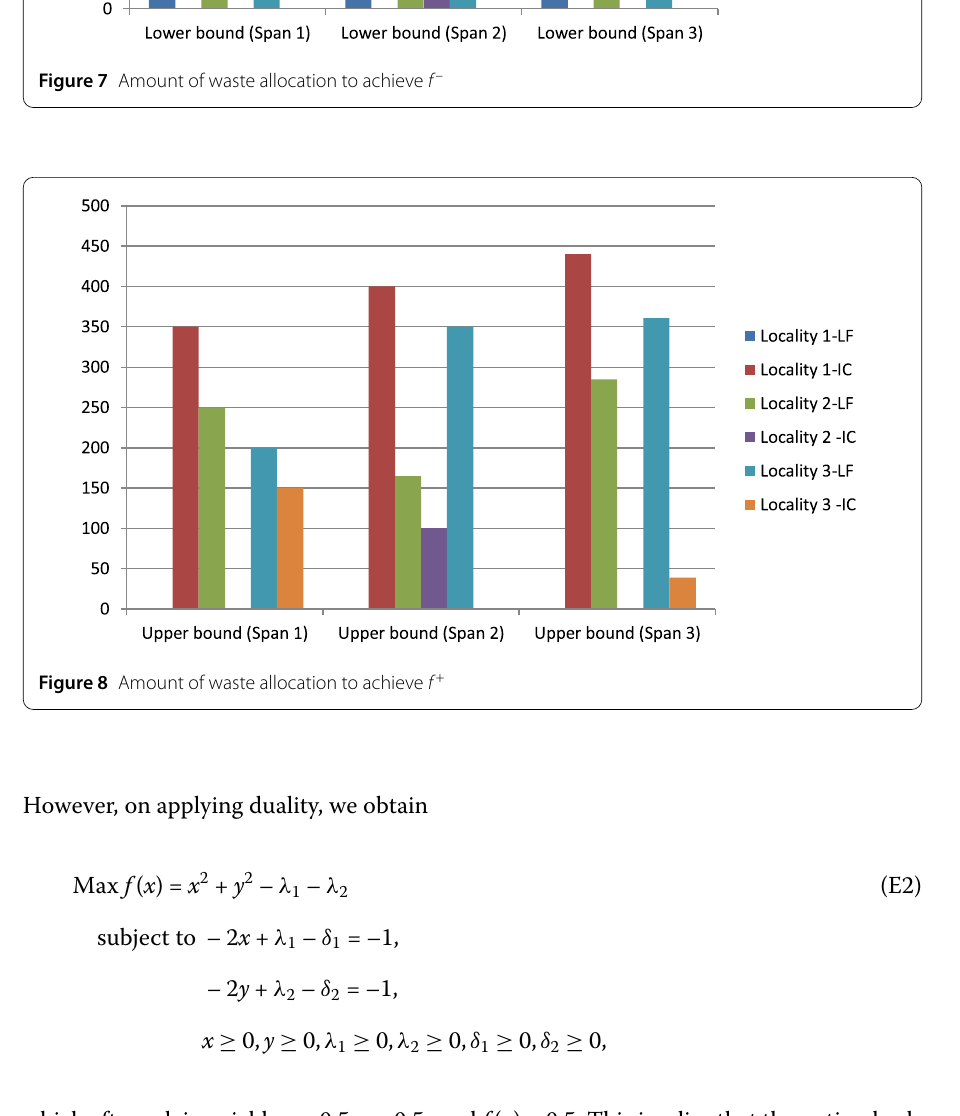
which after solving yields x = 0.5, y = 0.5, and f ( x ) = 0.5. This implies that the optimal val- ues of (E1) and (E2) are not the same. It shows that duality is not applicable in (E1) as it is not a convex optimization problem (see p. 232, Bazaraa et al.